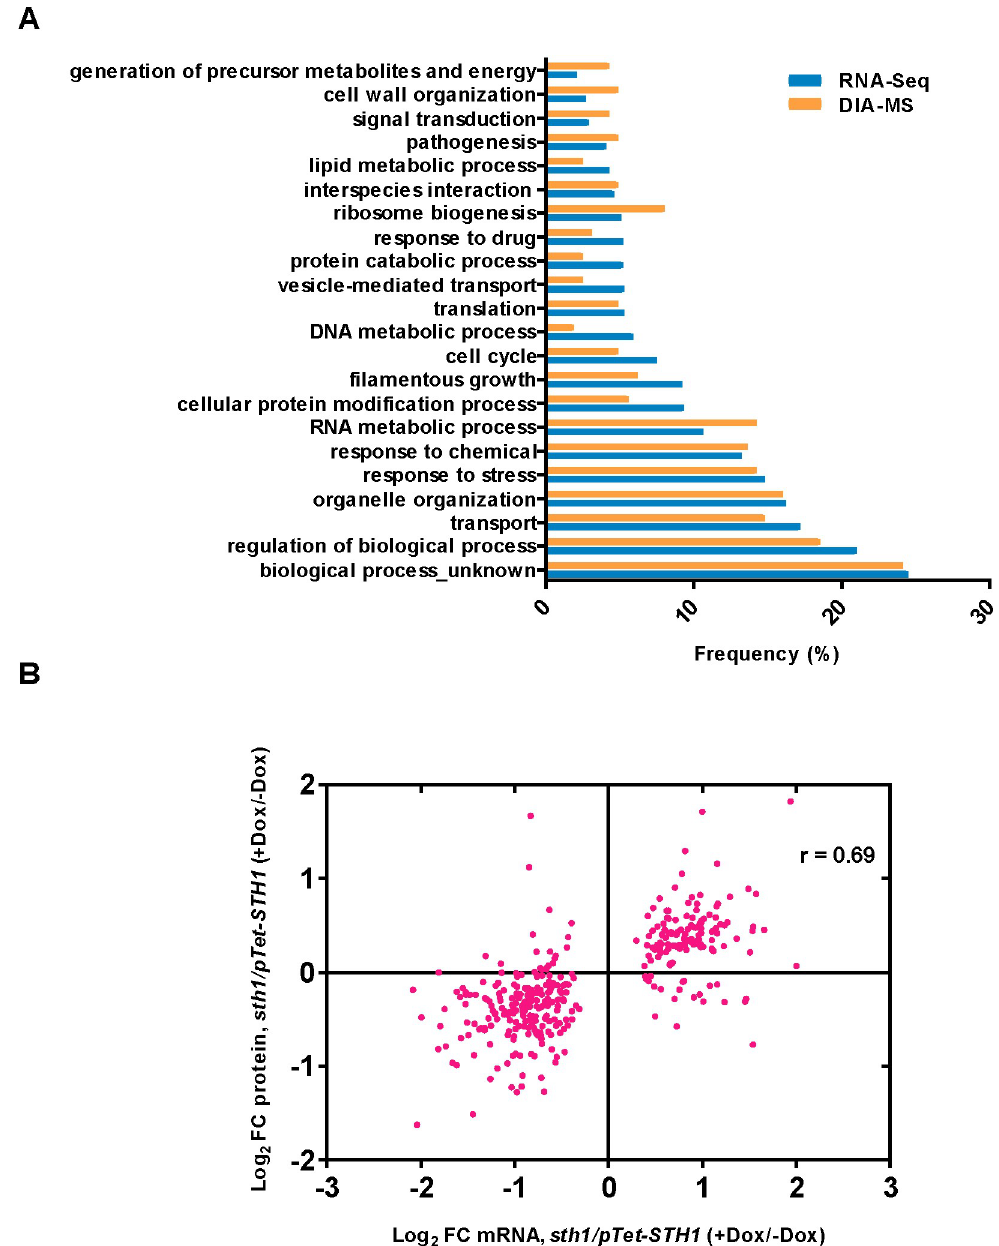
Fig 2. sth1 mutant gene expression profiles show global roles of RSC in C . albicans . A . Sth1-dependent biological processes inferred by Gene Ontology (GO) analysis of differentially expressed genes (RNA-Seq, blue bars) and proteins (DIA-MS, orange bars). Y-axis represents the various GO terms of ‘biological process’, mapping to the expression dataset of sth1/pTet-STH1 (SGC2001), while the x-axis denotes the frequency with which a specific GO term mapped to the candidate list provided. Raw data underlying graph given in S7 Table. B. Scatter plot depicting the relationship between the RNA-Seq (transcriptomic) and DIA-MS (proteomic) datasets of sth1/pTet-STH1 (SGC2001) mutant. Pink dots in the plot represent proteins identified with their corresponding genes in the RNA-Seq dataset. The log2 FC (fold change) values of mRNAs (5% FDR) along with their corresponding protein log2 fold change values (5% FDR) are represented on x-axis and y-axis, respectively. The Pearson’s correlation coefficient ( r ) is indicated on the top right corner of the plot. Raw data underlying graph given in S7 Table.